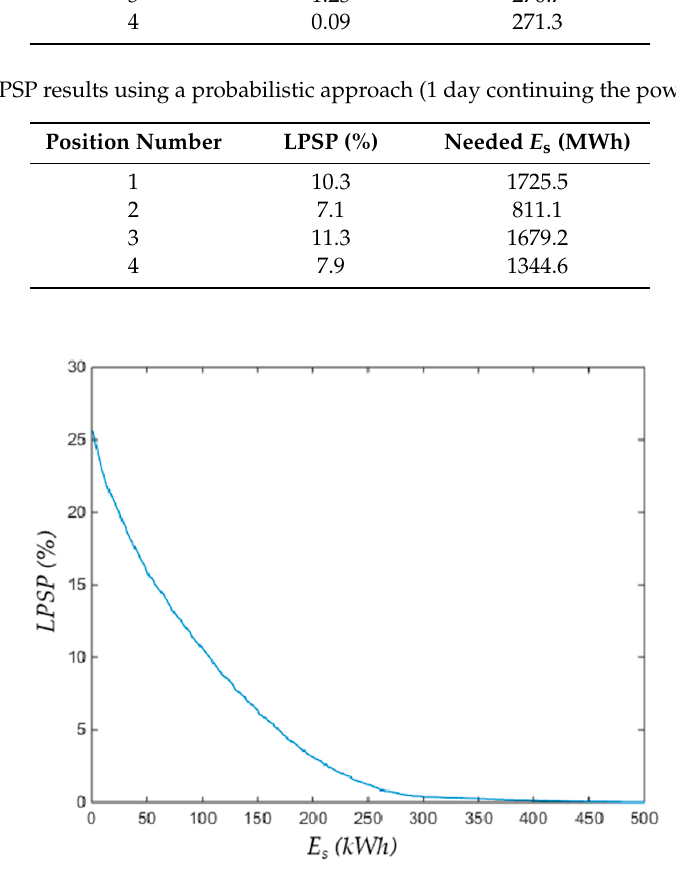
Figure 10. The variations of the loss of power supply probability (LPSP) with the E s ( P r = 100 kW, P m = = 100 kW, and L = 20 100 kW, and L = 20 kW). P m